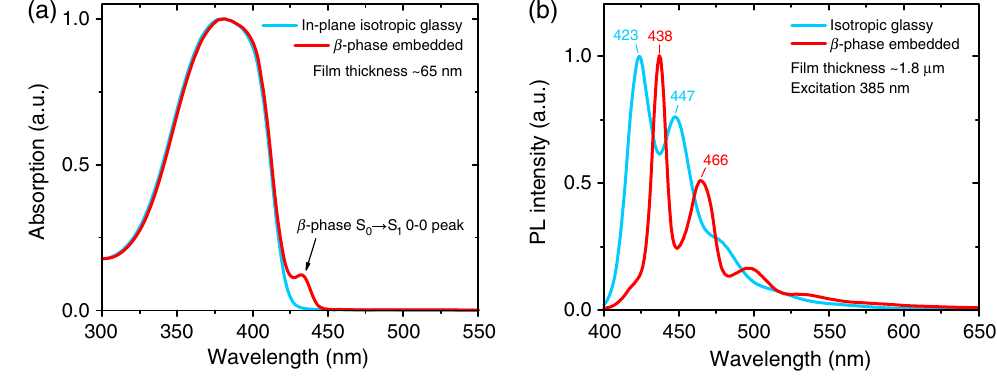
FIG. 18. Optical spectroscopy of HMW PFO films of two distinct microstructures due to varied processing: isotropic glassy (blue line) via spin coating at elevated temperature, β -phase embedded (red line) via toluene solvent vapor exposure to pristine glassy films. (a) Peak-normalized absorption spectra for thin ( ∼ 65 nm) films. (b) Fluorescent emission from glassy and β -phase embedded optically thick ( ∼ 1 . 8 μ m) PFO layers that were used in TOF measurements. Signature wavelengths of the emission peaks in both cases are labeled. Note in the β -phase embedded PL a 420-nm glassy S 1 → S 0 0-0 shoulder. The PL spectra were recorded with excitation at 385 nm.